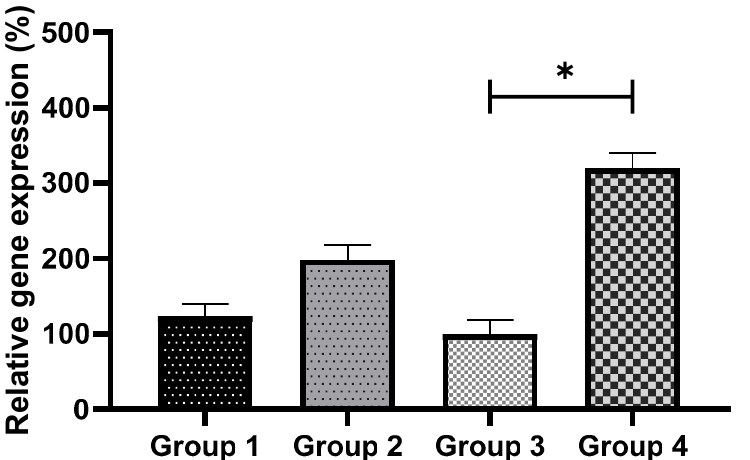
Figure 10. The effect of GSH supplementation on Bcl2 gene expression in non-vitrified and vitrified groups. Data are expressed as the means ± SEM. * p < 0.05. Group 1 (GSH-free medium); Group 2 (GSH-supplemented medium); Group 3 (GSH-free medium with vitrification); Group 4 (GSH-supplemented medium with vitrification).